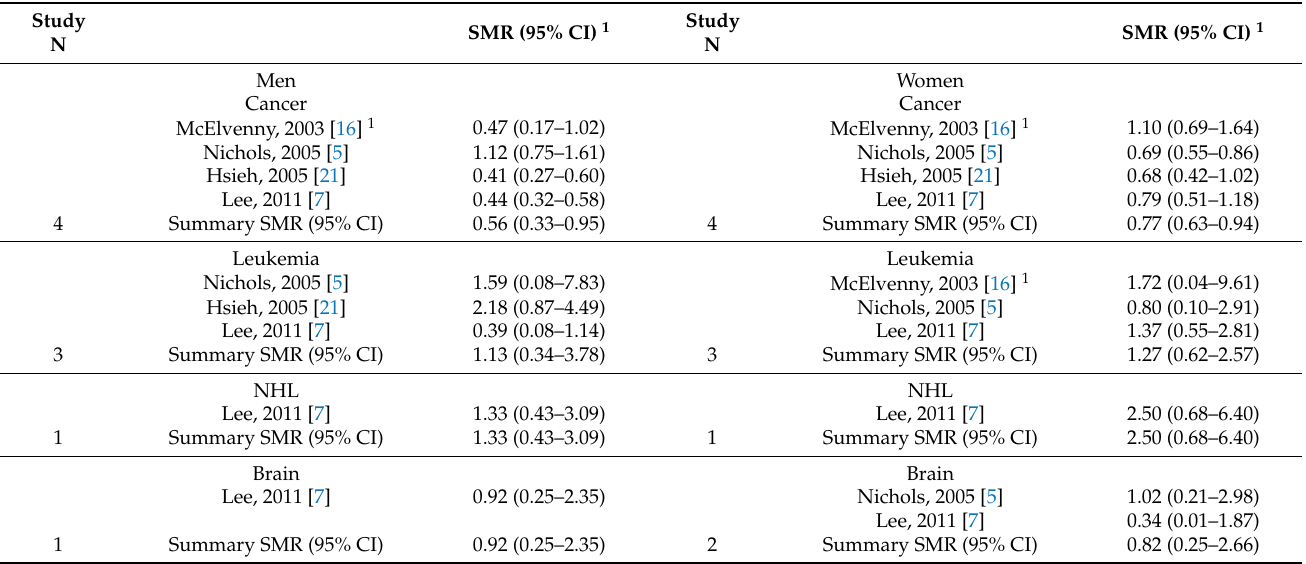
Table 4. Sex-specific meta-analysis for the standardized mortality ratios (SMRs) of cancer, leukemia, NHL, and brain tumor in semiconductor workers compared to the general population.